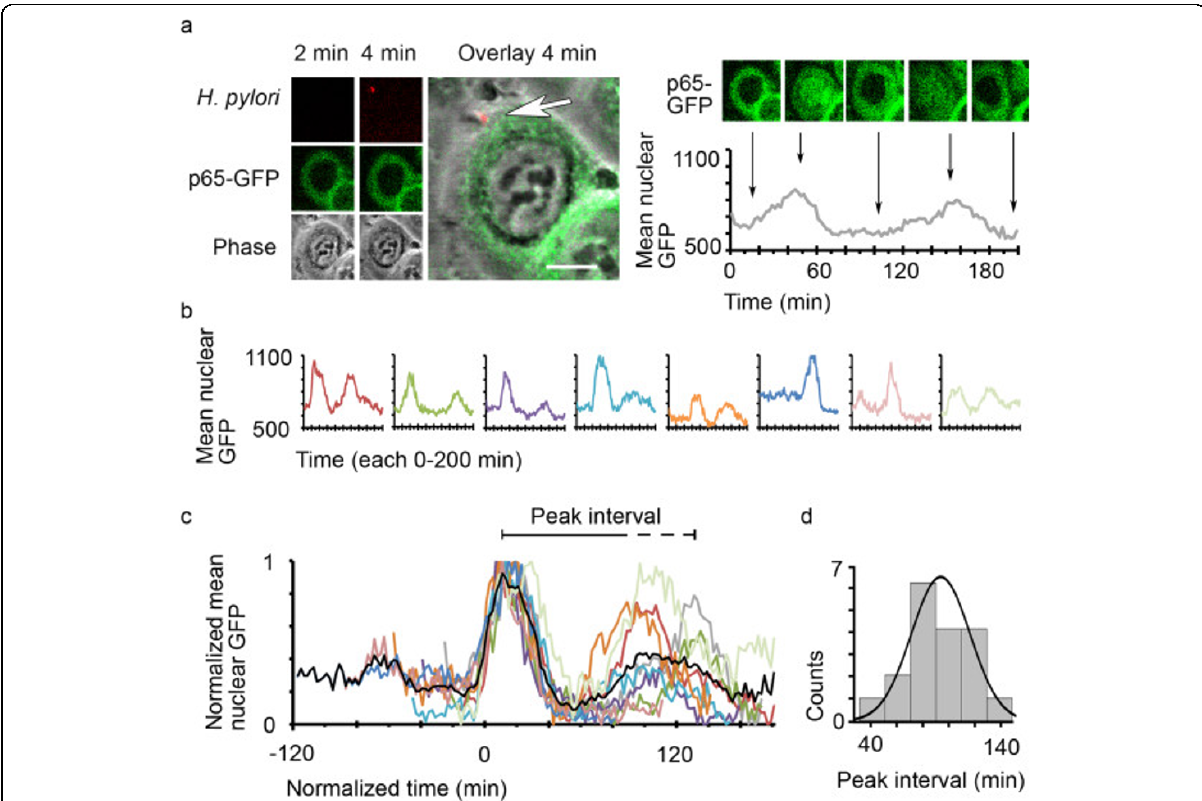
Figure 4 H. pylori induces damped oscillations of p65 nuclear translocations . a) p65-GFP expressing AGS SIB02 cells were infected with H. pylori , stained with Syto 61 and analyzed by confocal live-cell microscopy. The upper panel shows a single bacterium attaching to a cell shortly after acquisition begins (arrow indicates position of bacterium). Graph shows average intensity of GFP in a representative nuclear region of this cell. Scale bar = 10 μ m. b) Graph shows average intensities of GFP in other cells from the same experiment, to which one or more bacteria attached at different time points. c) Alignment of normalized average intensities of GFP within representative nuclear regions of the nine single cells shown in (a) and (b). Mean GFP intensity of these nine cells is shown as a black line. While the first peak is remarkably similar, the peak interval and the second peak differ between cells. d) Peak interval of oscillating cells ranges from 40 and 140 minutes; intervals between